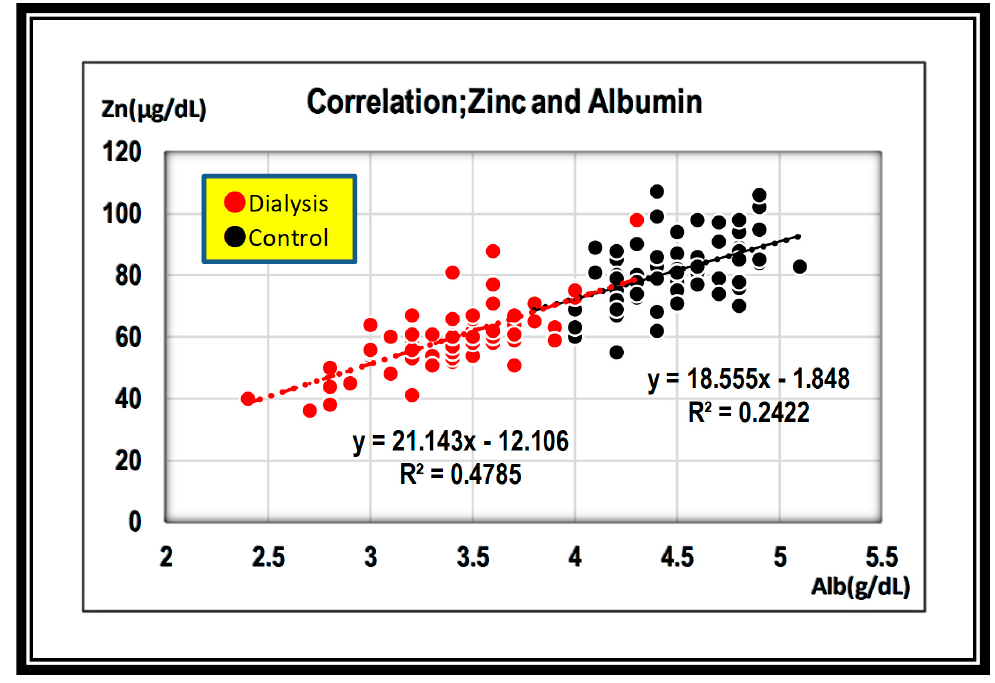
Figure 3. Regression line between zinc and albumin is positive in both groups. ● ； dialysis group, ● ； control group.